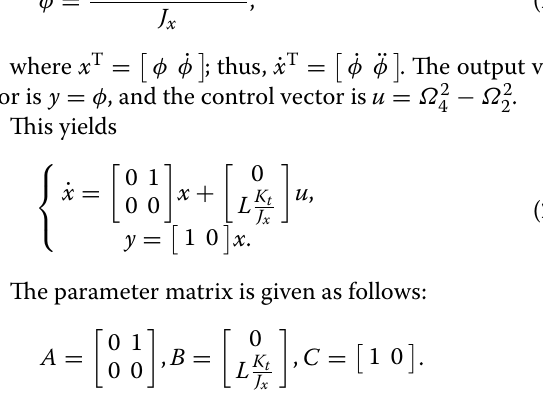
width is predetermined in the frequency-sweep design.